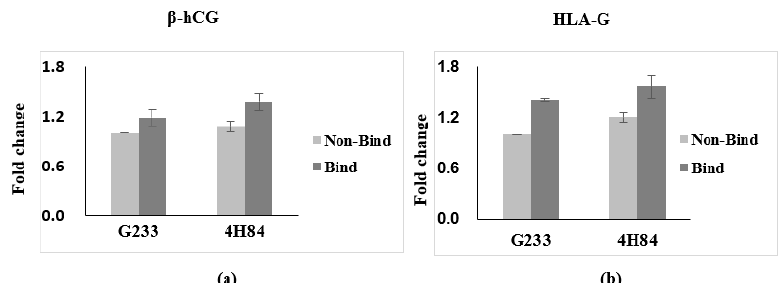
Figure 2. Expression of β -hCG and HLA-G in trophoblast cells with HLA-G antibody capture. ( a ) Expression of β -hCG in trophoblast cells increased with more 4H84 antibody than G233 antibody. ( b ) Expression of HLA-G in trophoblast cells increased with more 4H84 antibody than G233